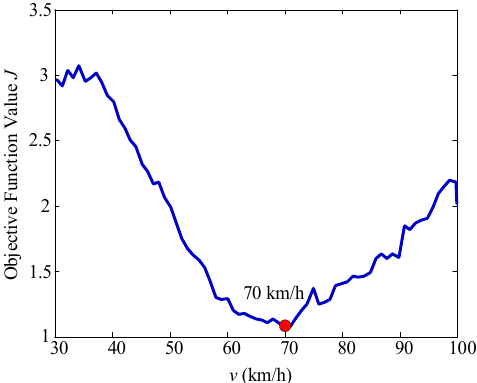
Figure 11. The objective function value under coupled road excitation.